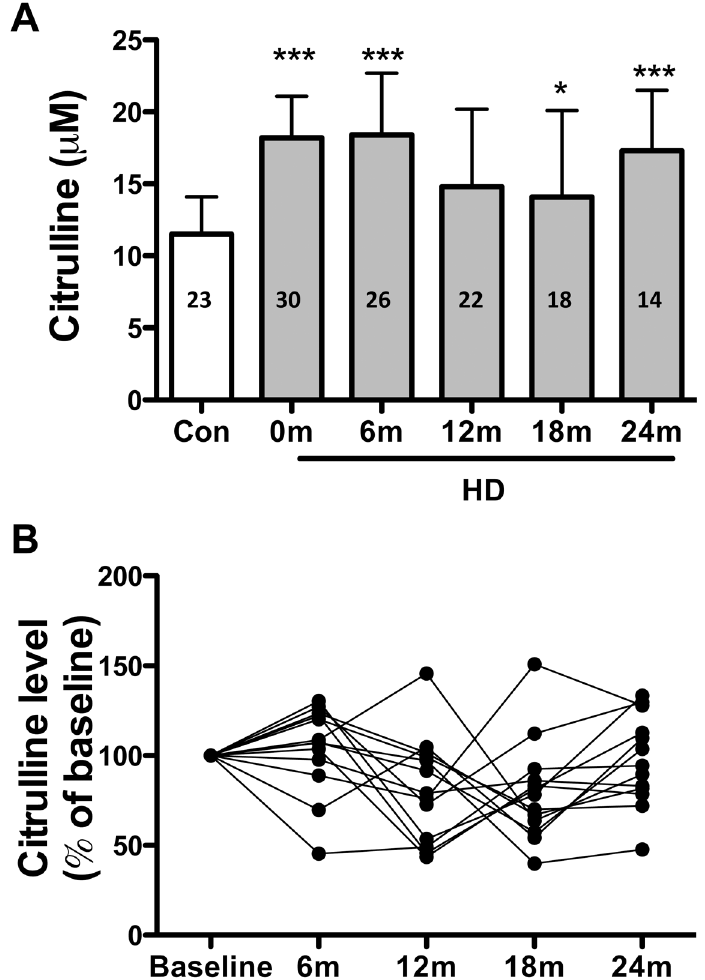
Fig 2. Blood citrulline concentration during follow-up of Huntington ’ s disease (HD) patients. Blood citrulline concentration was measured every 6 months and was compared at each time point with the concentration in non-HD controls (dotted line). The N value in the bar represents the number of collected data at each point (A). All data were normalized to the baseline value and show the progression pattern (B). Data are presented as mean ± standard deviation, * p < 0.05, *** p < 0.001 by t